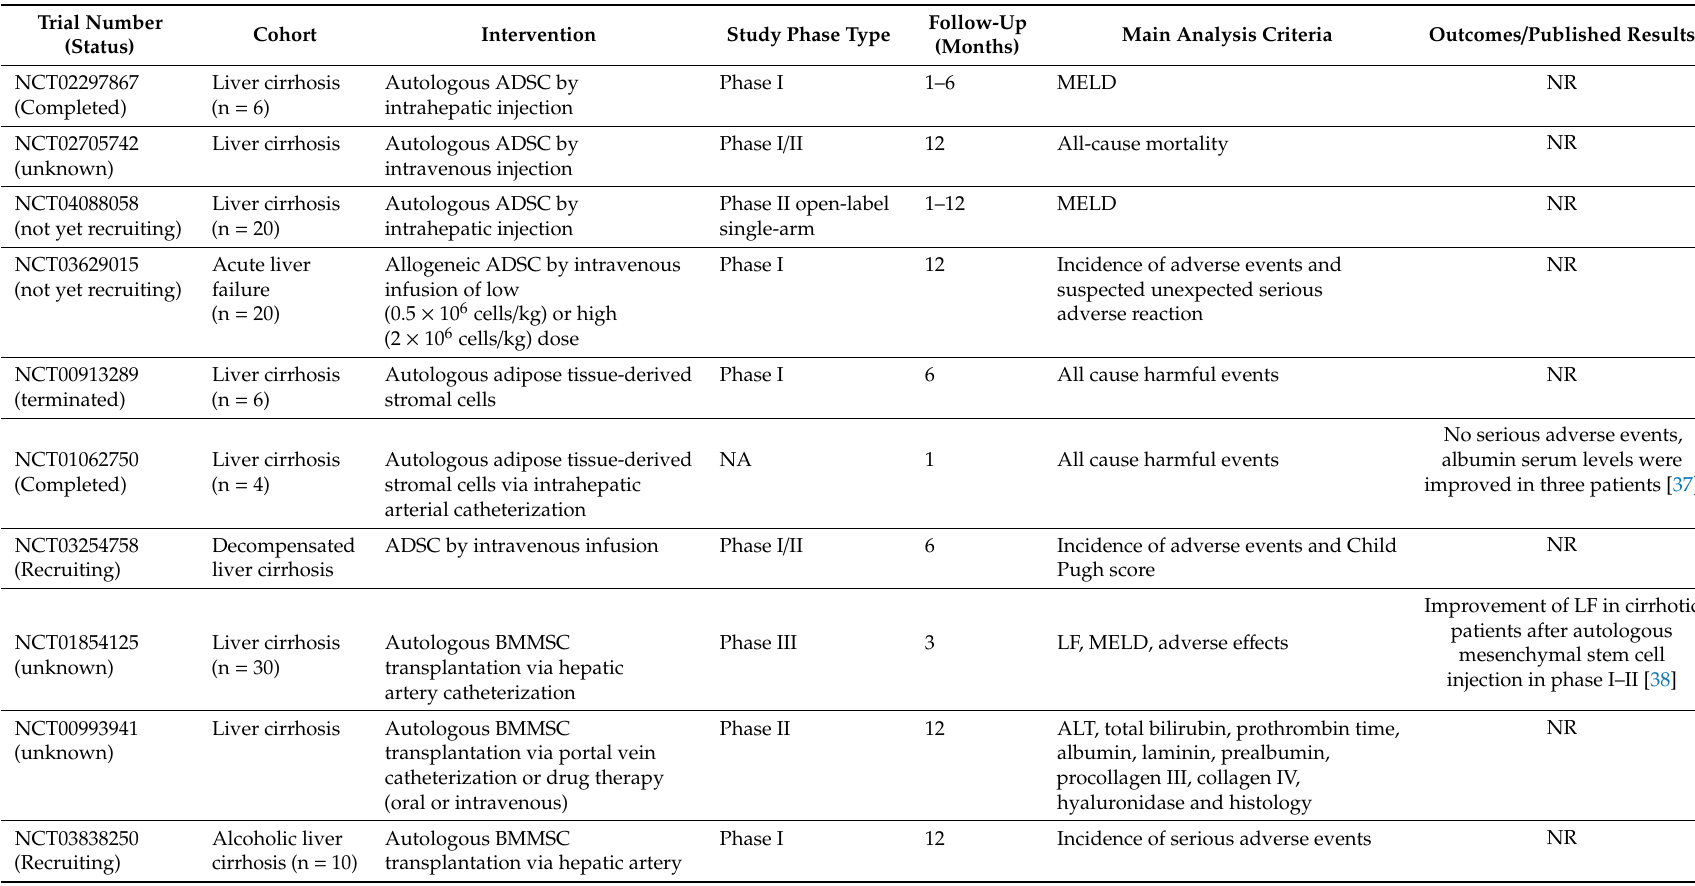
Table 2. Clinical trials using cells as therapeutic agents for inhibition of liver fibrosis / cirrhosis, registered under ClinicalTrials.gov